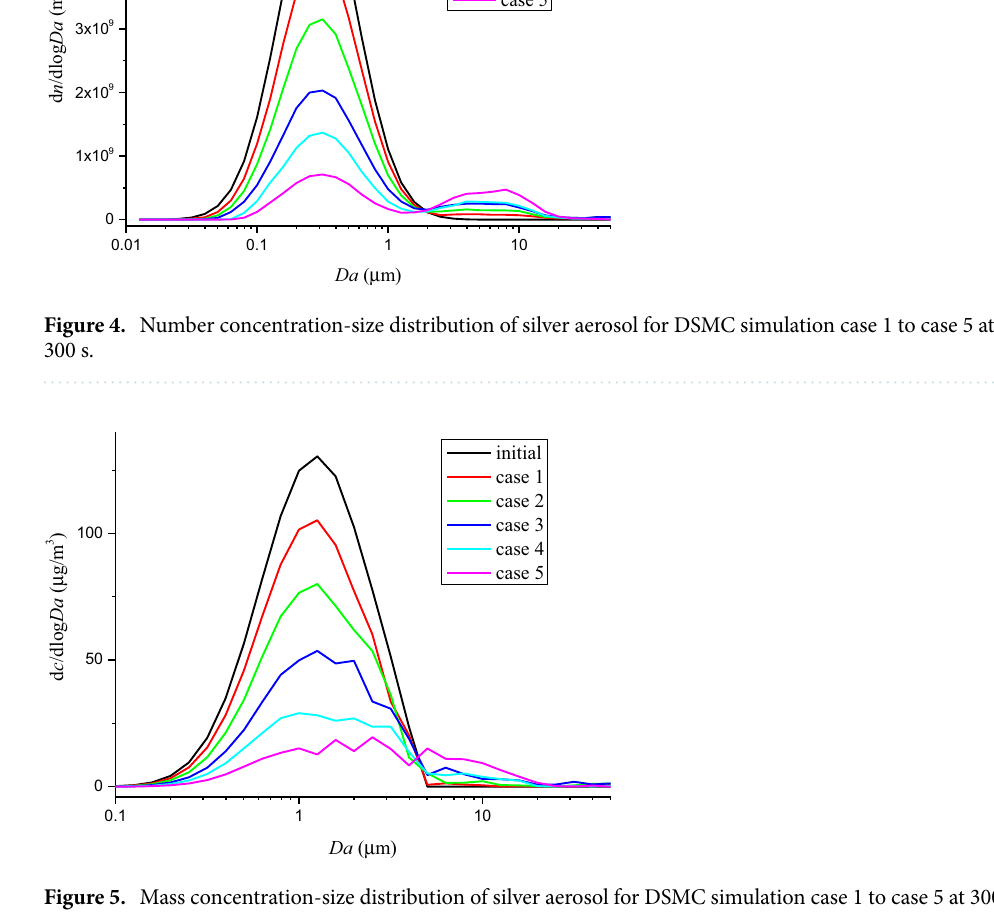
Figure 5. Mass concentration-size distribution of silver aerosol for DSMC simulation case 1 to case 5 at 300 s.